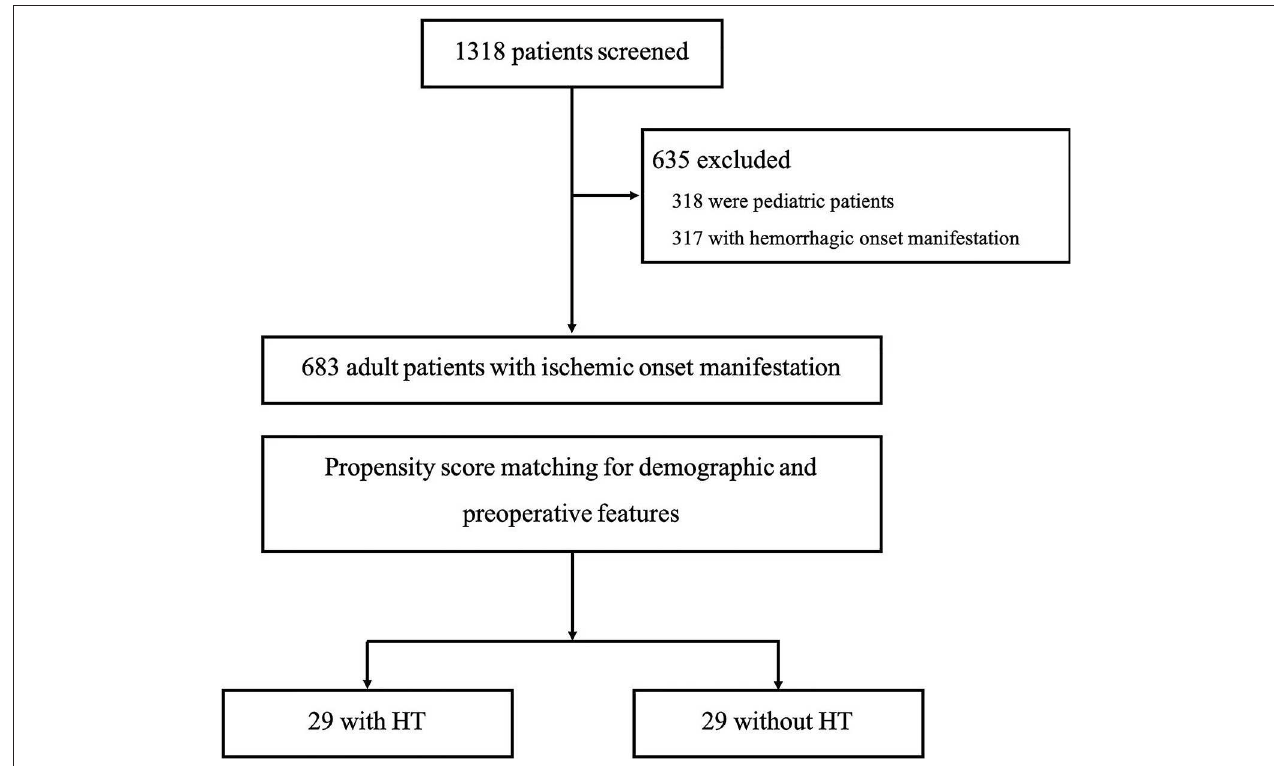
FIGURE 1 | Flow diagram of study